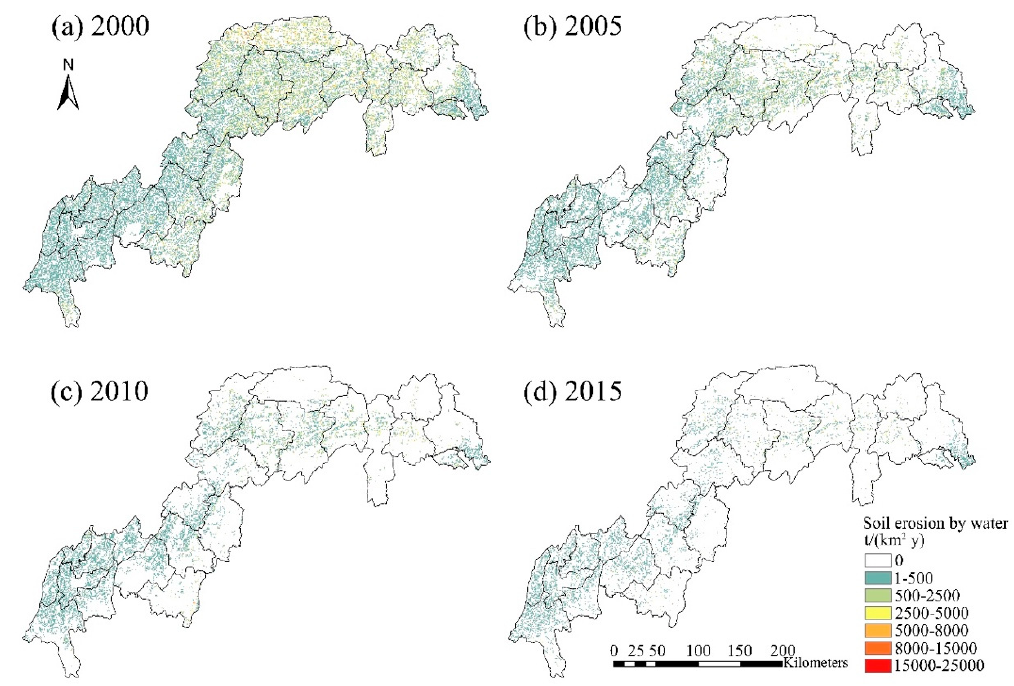
Figure 8. Spatial patterns of annual soil erosion by water in the Three Gorges Reservoir Region in 2000, 2005, 2010 and 2015. Table 3. Changing soil erosion grades in the Three Gorges Reservoir Region between 2000 and 2015. The soil grade classification accords to the Ministry of Water Resources of China (SL190-2007).